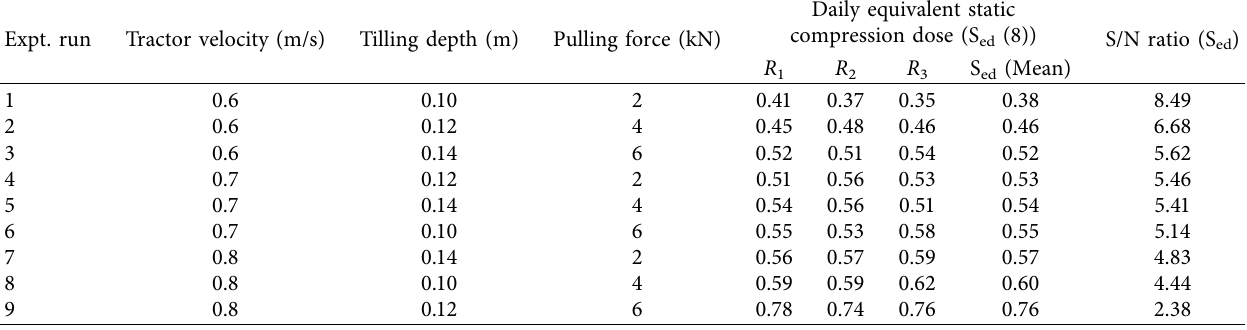
Table 1: S/N ratio of daily equivalent static compression dose (s